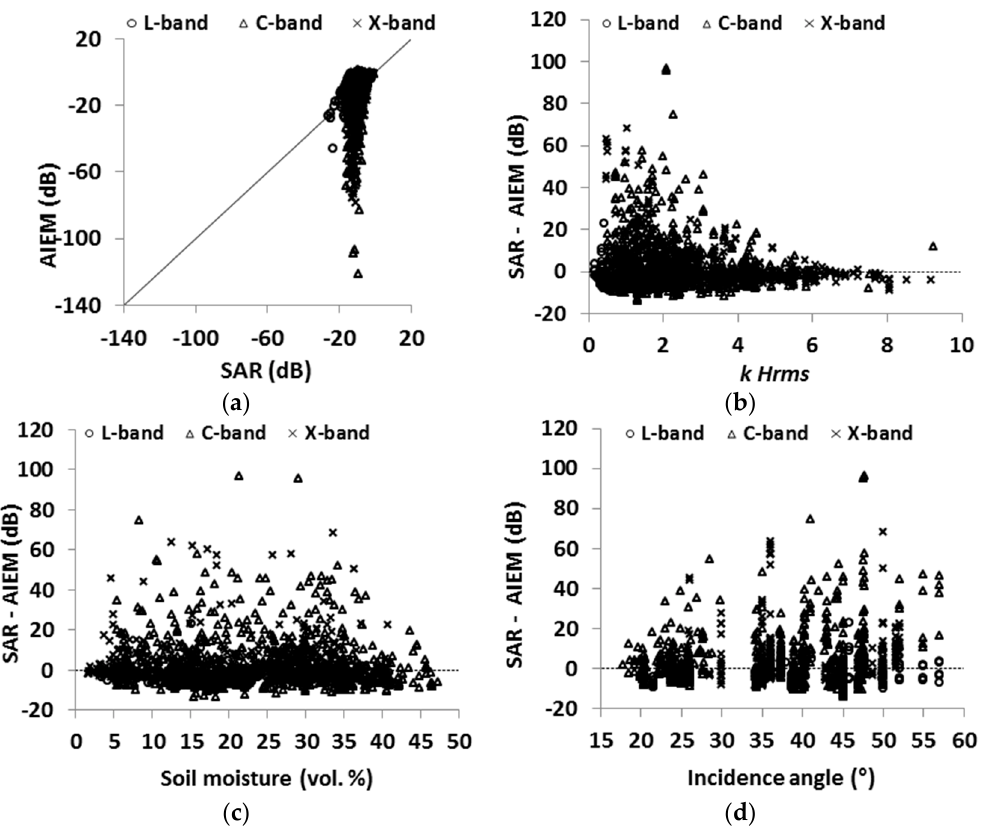
Figure 15. Comparison between backscattering coefficients derived from SAR images and those estimated from AIEM at HH polarization using GCF. ( a ) AIEM simulations vs. SAR data; ( b ) difference between SAR signal and AIEM vs. soil roughness ( kHrms ); ( c ) difference between SAR signal and AIEM vs. soil moisture ( mv ); ( d ) difference between SAR signal and AIEM vs. incidence angle.